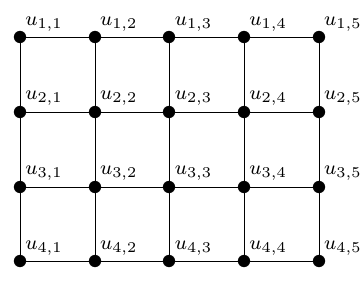
Figure 1: Grid graph P